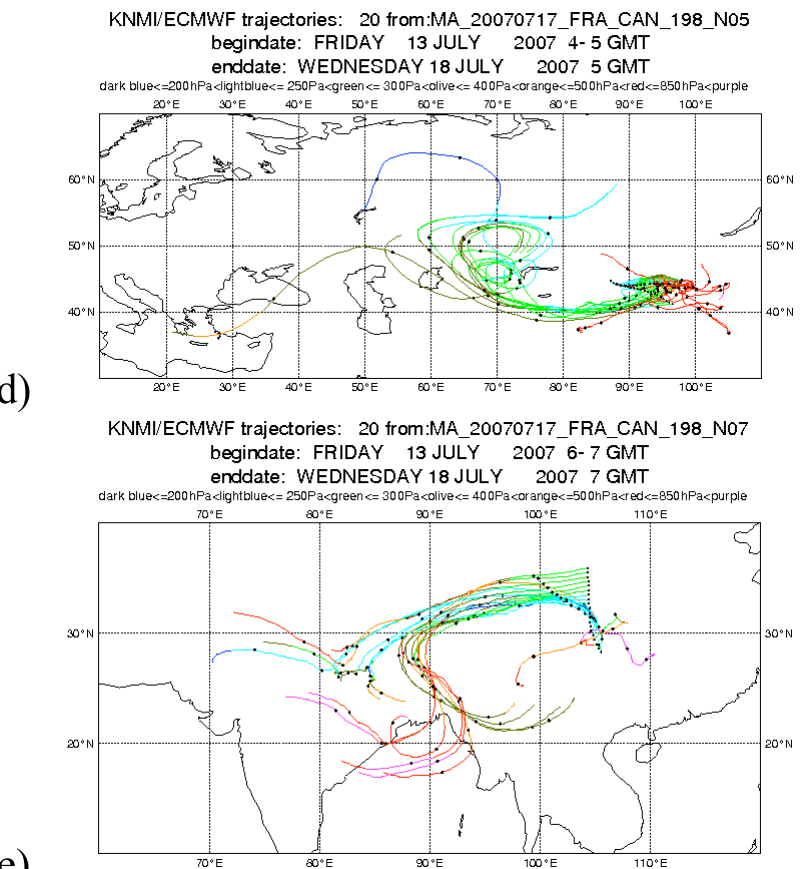
Fig. 9. Figure 9. KNMI/ECMWF 5-day air mass back-trajectories. Coordinates and dates of arrival points correspond to plumes sampled along the 2006 and 2007 July flights ( Figure 2 ).